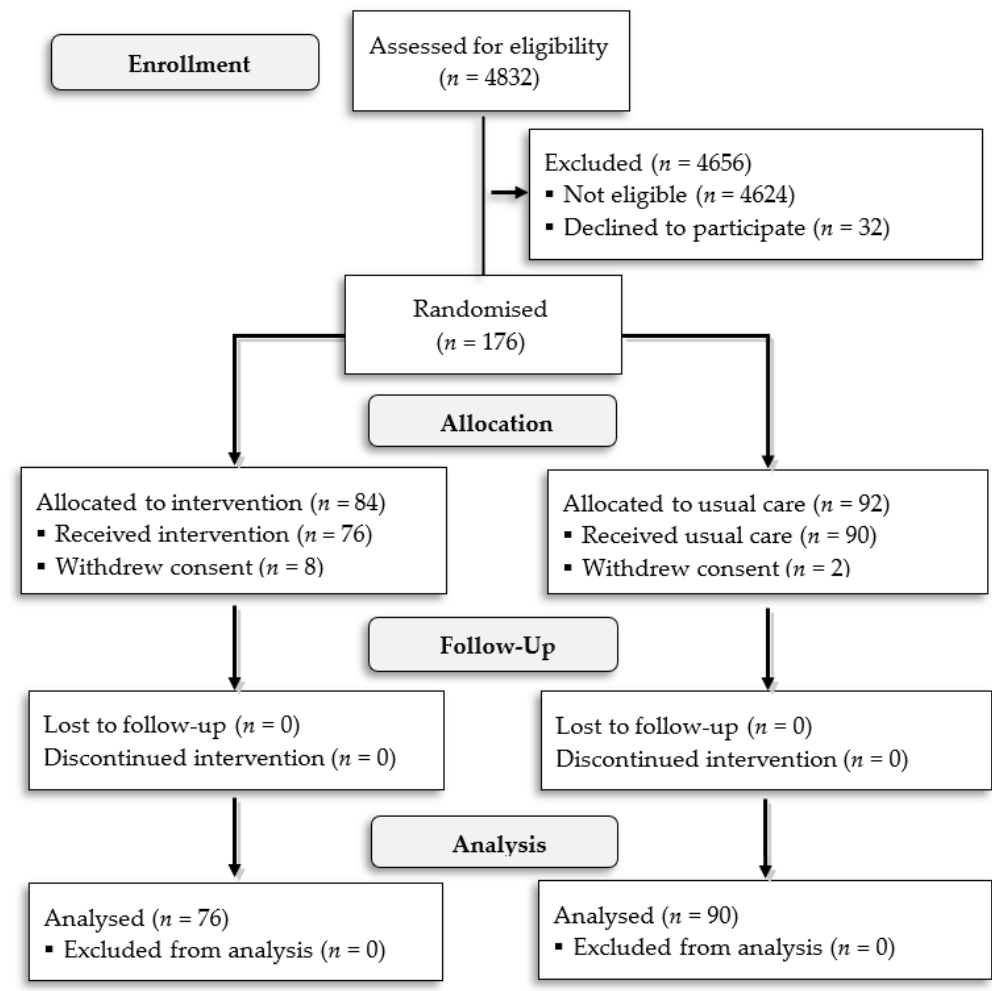
Figure 3. CONSORT diagram showing patient flow through the trial.